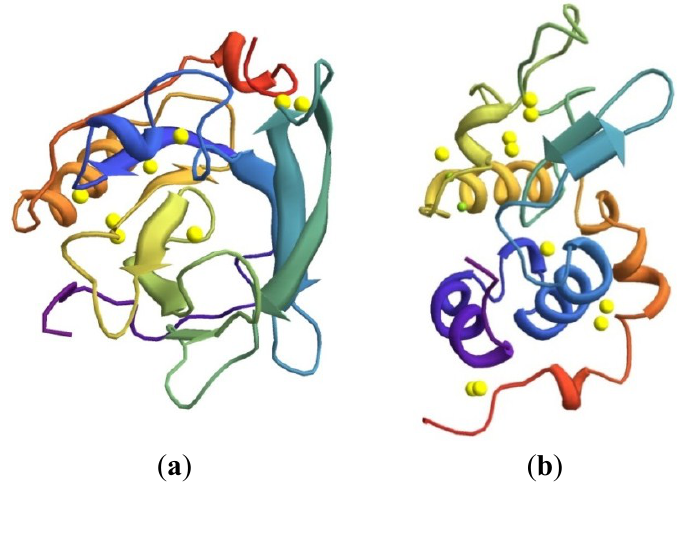
Figure 1. Tertiary structure of ( a ) β-lactoglobulin and ( b ) α-lactalbumin [52]. Figures are created with Wolfram Mathematica 9.0 based on protein data from